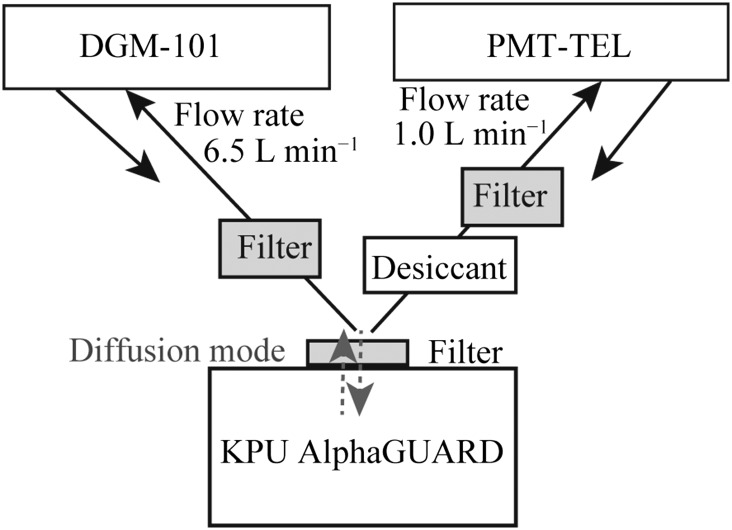
Schematic diagram of three experimental devices.